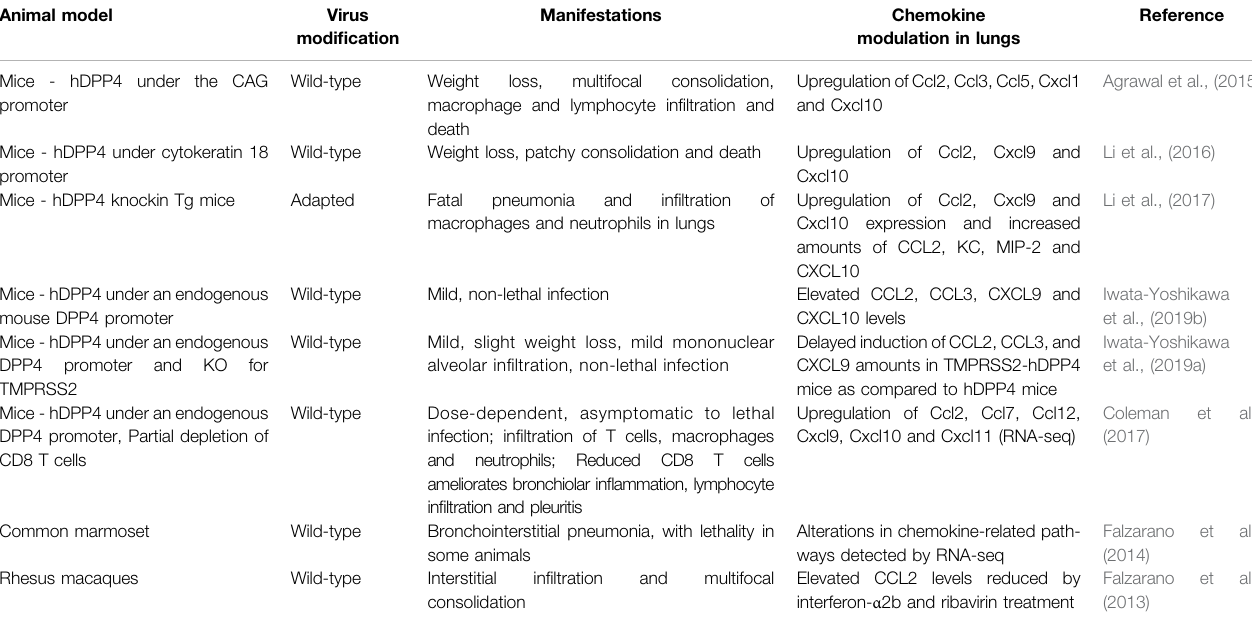
Table 3 | Chemokine regulation in the lungs of animal models of MERS-CoV-induced viral pneumonia. Animal